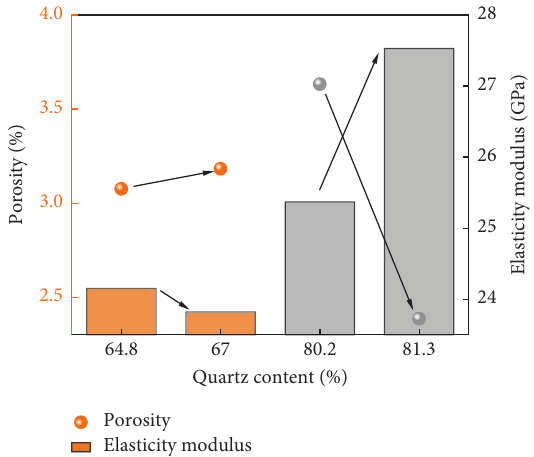
Figure 10: Modulus of elasticity corresponding to shales with different quartz contents.